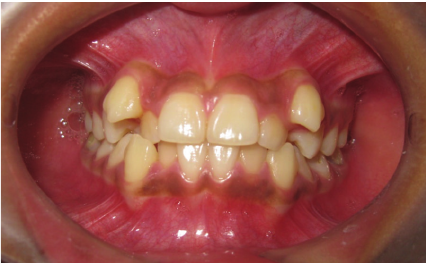
Figure 4: IOTN-AC Grade 8–10: definite need for orthodontic